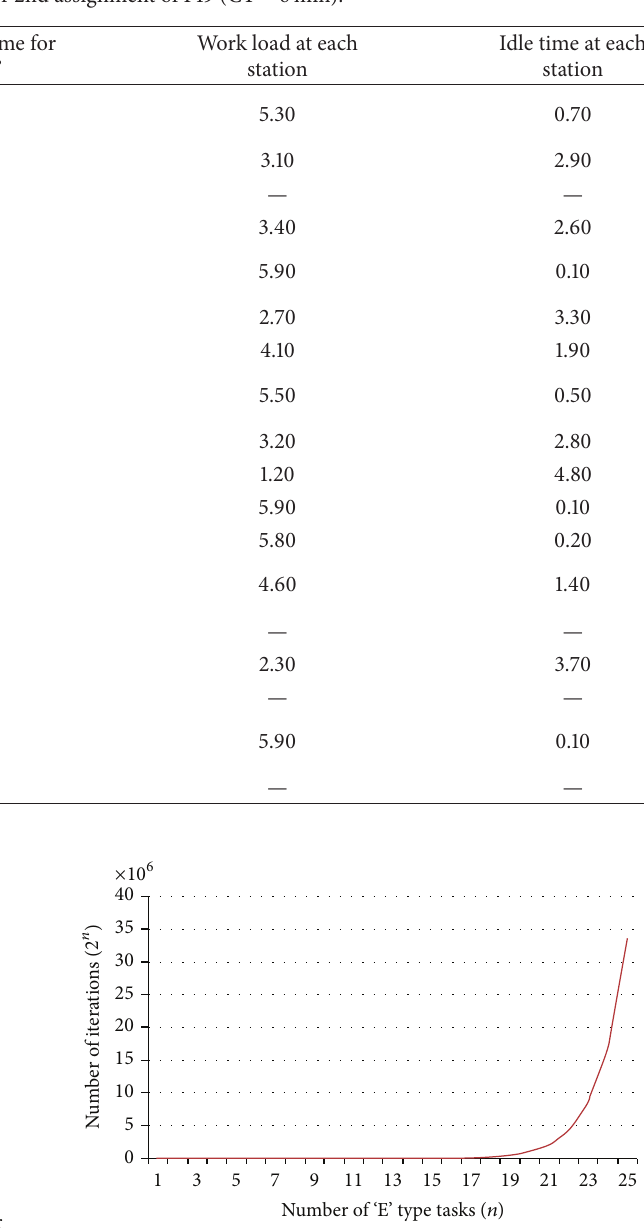
Figure 4: Pareto front for problem P19 of proposed EHA.